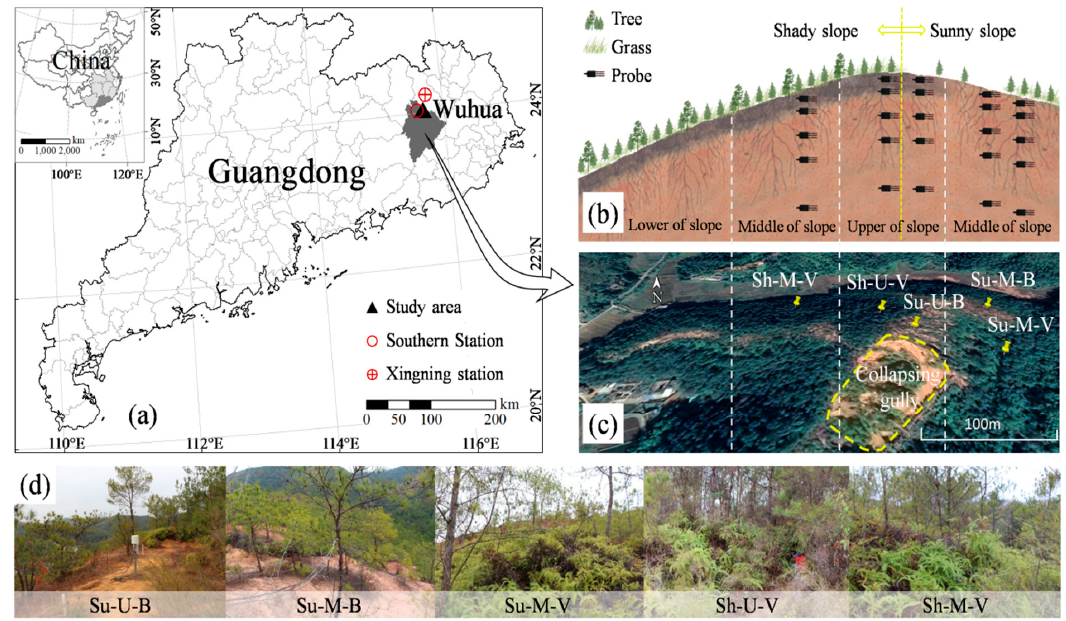
Figure 1. ( a ) The location of the study area. ( b ) The diagrammatic sketch of the experimental slope. ( c ) The image of studied collapsing slope with the five experimental sites. ( d ) The landscape of the five experimental sites.